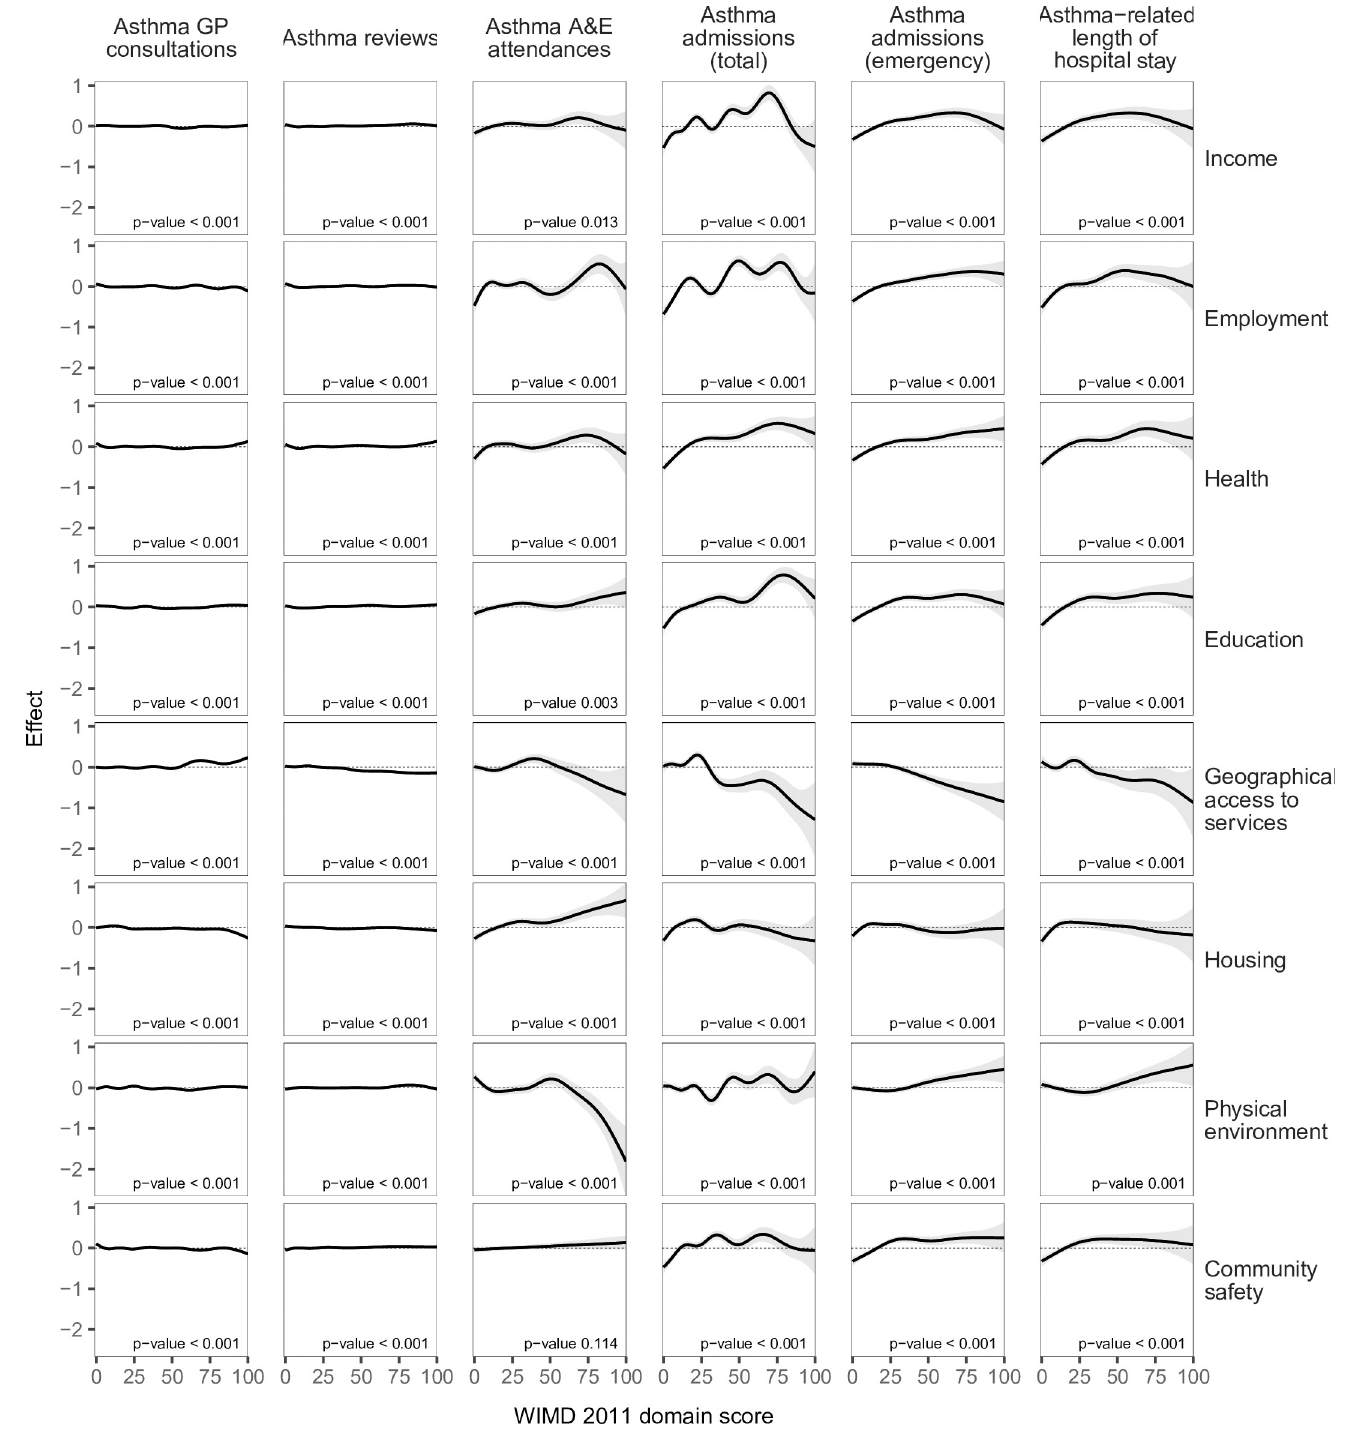
Fig 3. Smooths from separate GAMs of asthma-related health service utilisation variables against scores of the WIMD 2011 domains, controlled for age and gender. The shaded area represents the 95% CI of effect. A&E, accident and emergency; CI, confidence interval; GAM, generalised additive model; GP, general practitioner; WIMD, Welsh Index of Multiple